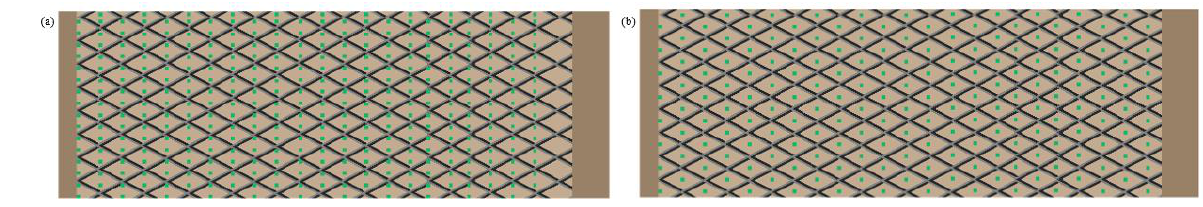
Figure 5. Schematic diagram with two vegetation densities. ( a ) High vegetation density; ( b ) Low vegetation density. Table 6. Low (high) density group